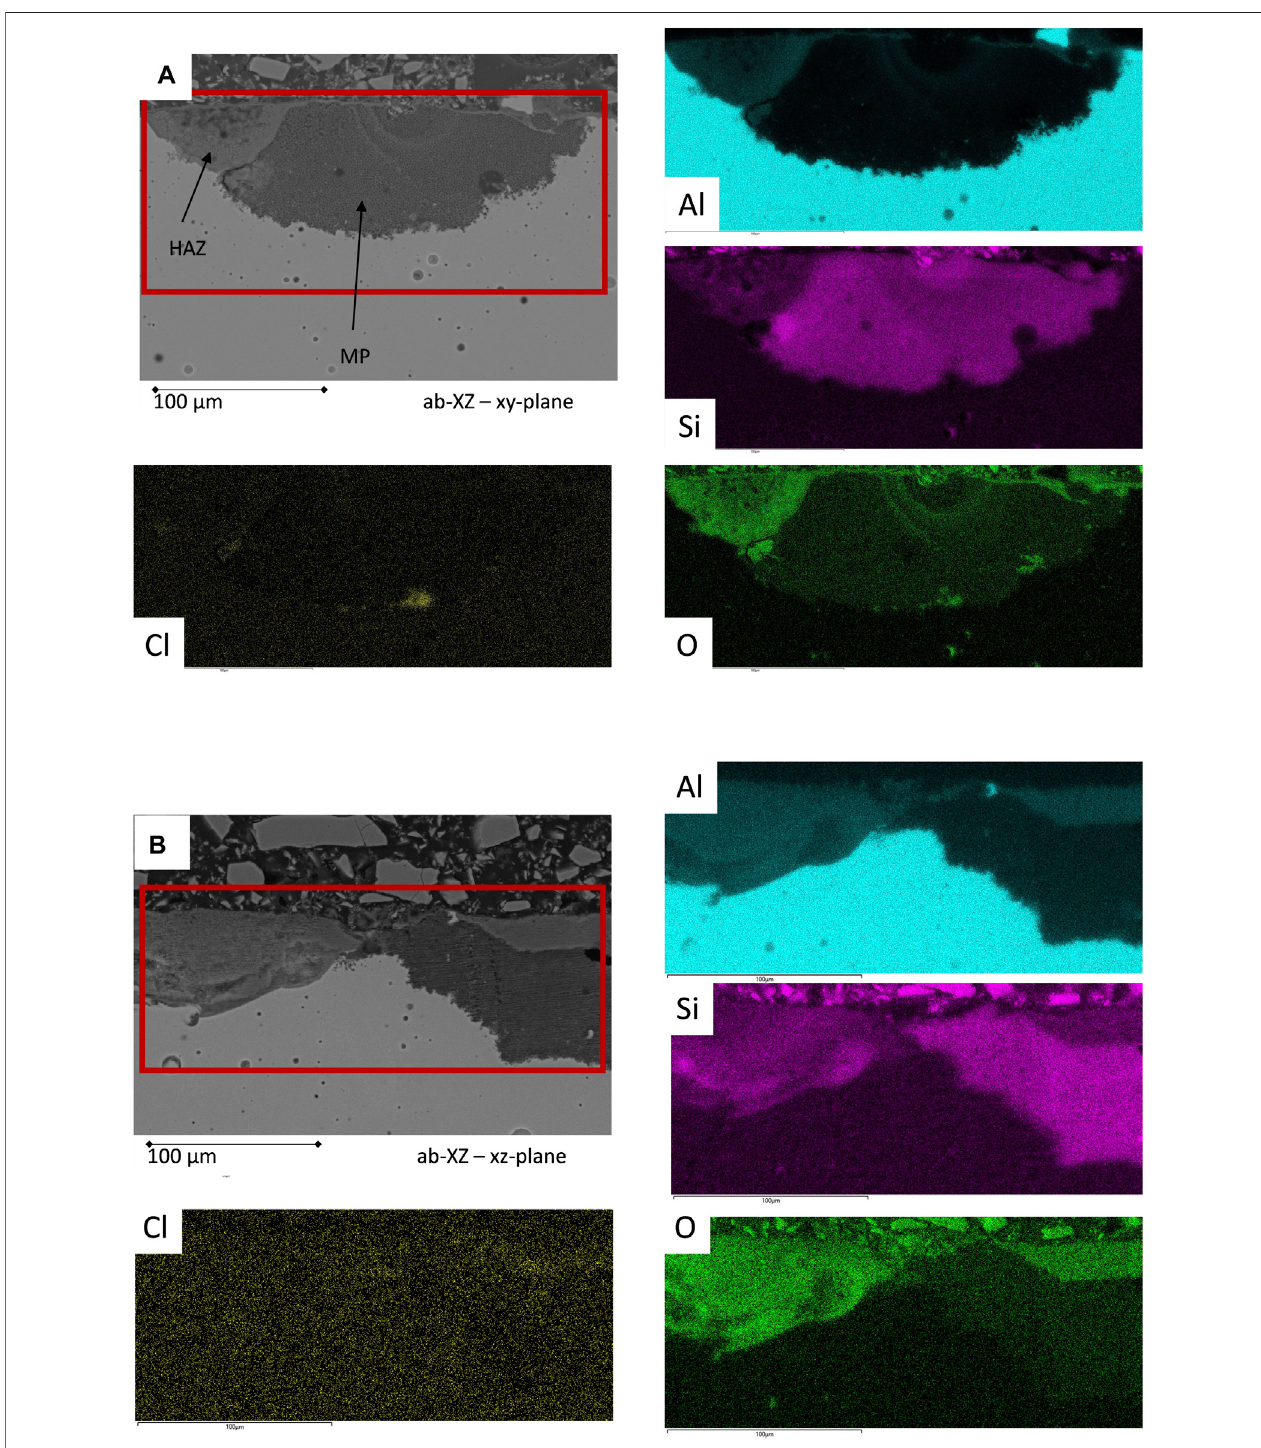
FIGURE 9 | EDS mapping analysis of the corrosion events of the untreated as-built surface after the corrosion test procedure; heat-affected zones (HAZ) show a discontinued Si network, while the melting pool (MP) exhibits an intact Si network.